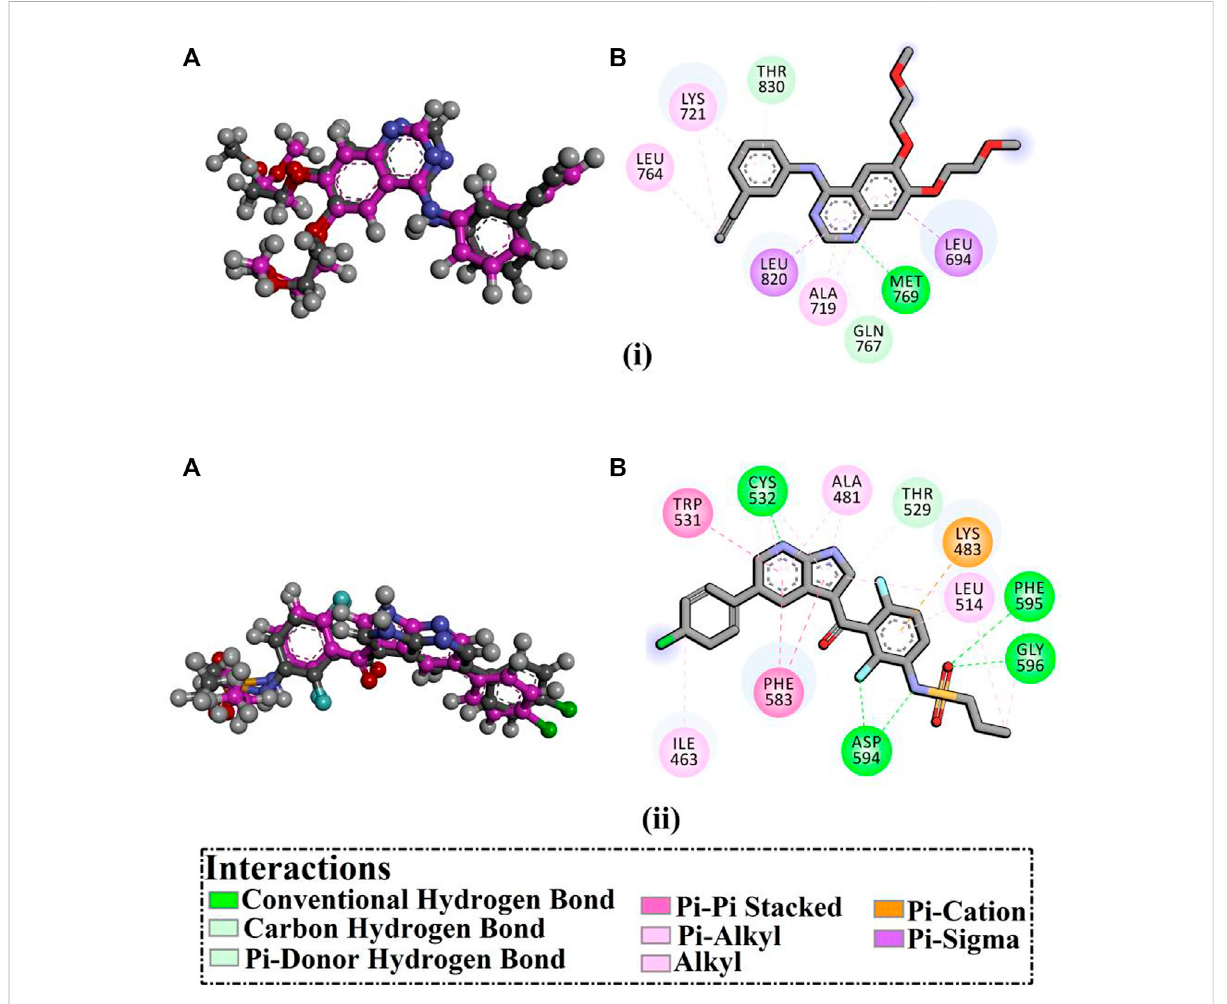
Supplementary Table S1. Based on the data enrolled in